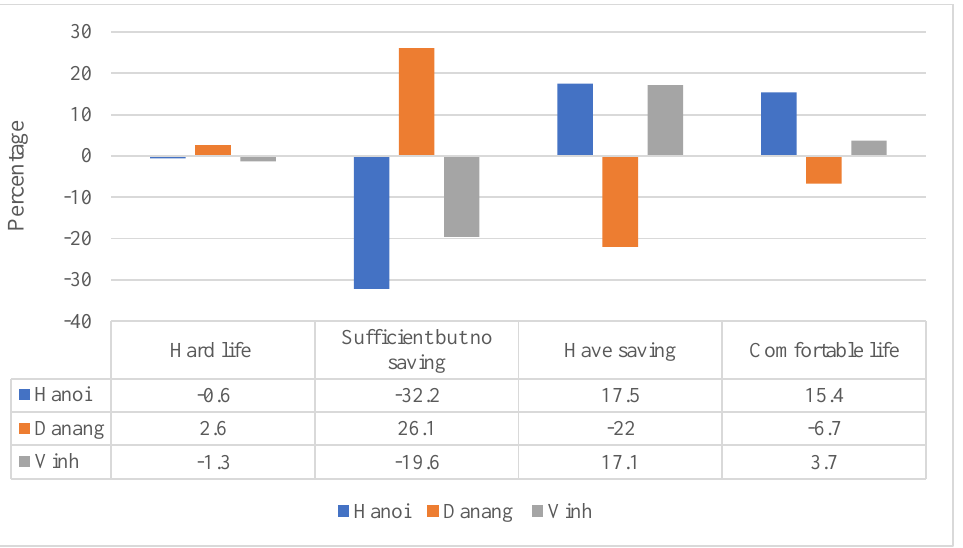
Figure 5. Changes in quality of life after land acquisition. Source: Household survey, 2019 and 2020.